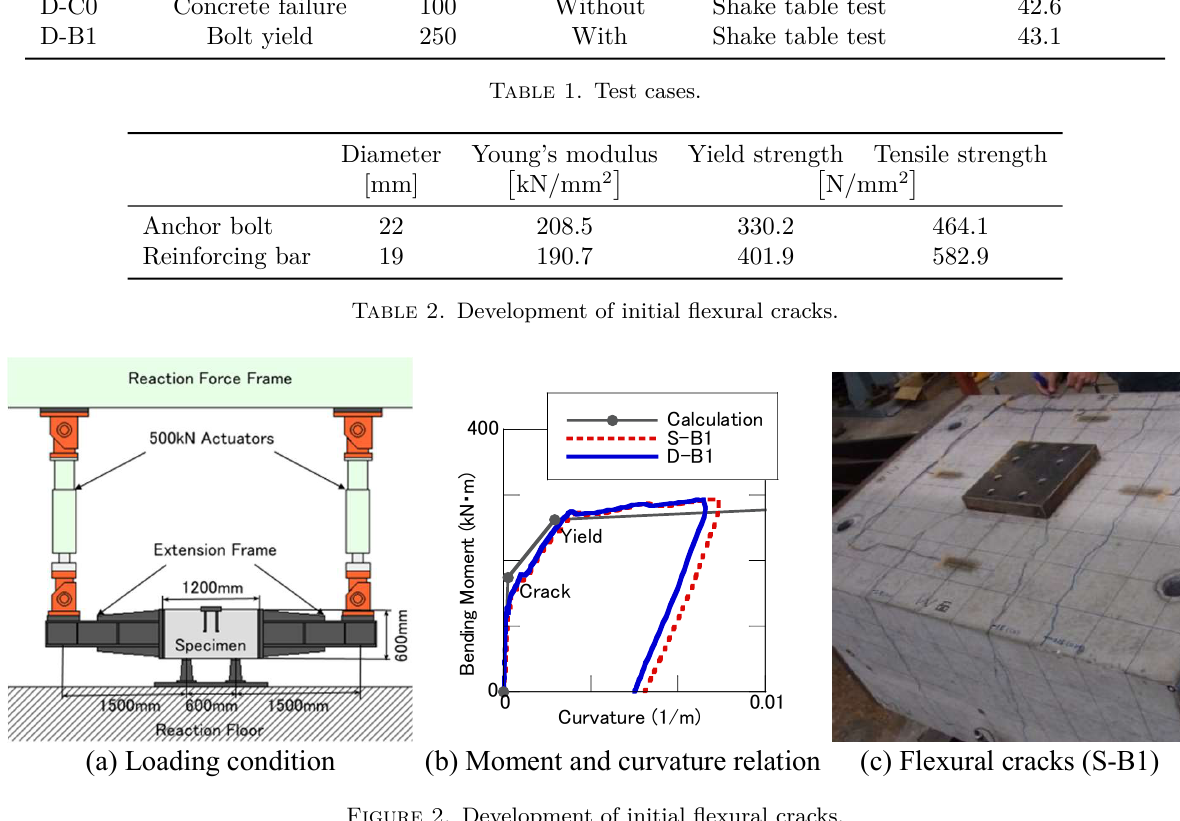
Figure 2. Development of initial flexural cracks.